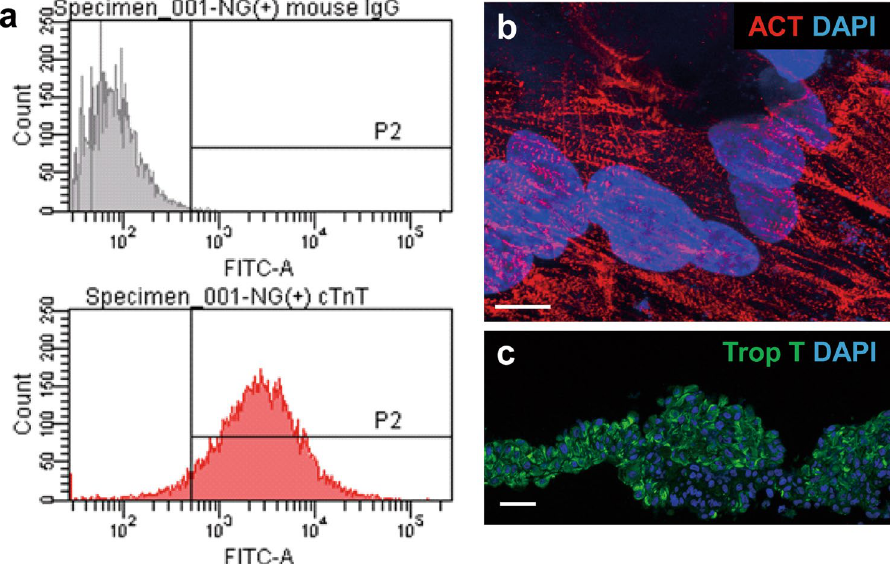
Figure 1. Characterization of hiPS-CMs and hiPS-CM cell sheet. ( a ) Expression of cardiac troponin T (cTNT) after differentiation and purification of hiPS-CMs was determined by flow cytometry anaysis. ( b ) After differentiation and purification, sarcomere structure was visualized by sarcomeric alpha actinin staining in hiPS-CM. ( c ) Immunostaining of the hiPS-CM cell sheet with cTNT antibody (green). The cell nuclei were counterstained with 4 ′ ,6-diamidino-2-phenylindole (DAPI; blue). Scale bar, 10 μ m in ( b ) and 100 μ m in ( c